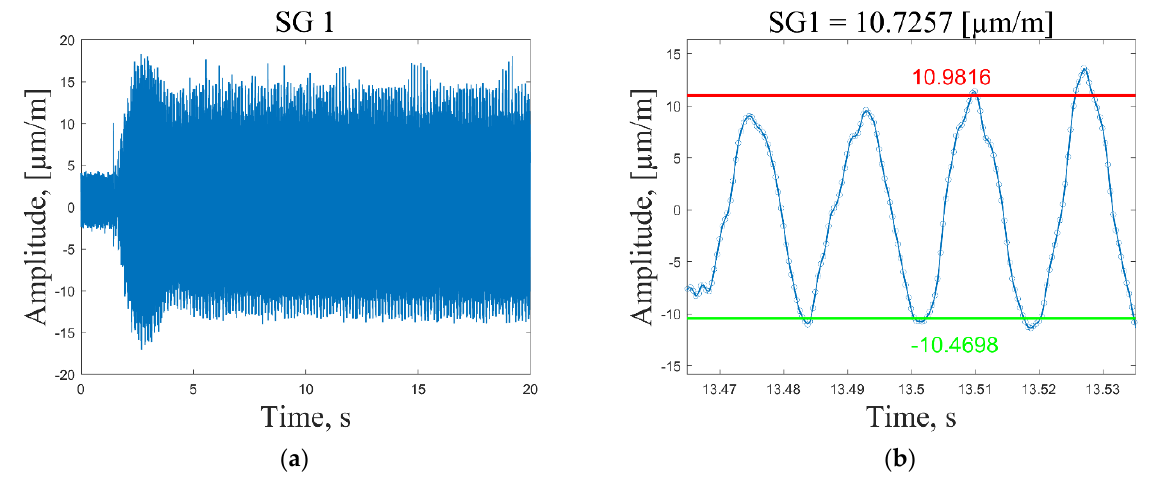
Figure 10. Recorded time series of strain response of the plate excited by a periodic sine wave signal corresponding to the first resonant frequency with a 1 V peak-to-peak vibration amplitude ( a ); calculated average peak-to-peak values for strain gauge 1 ( b ).